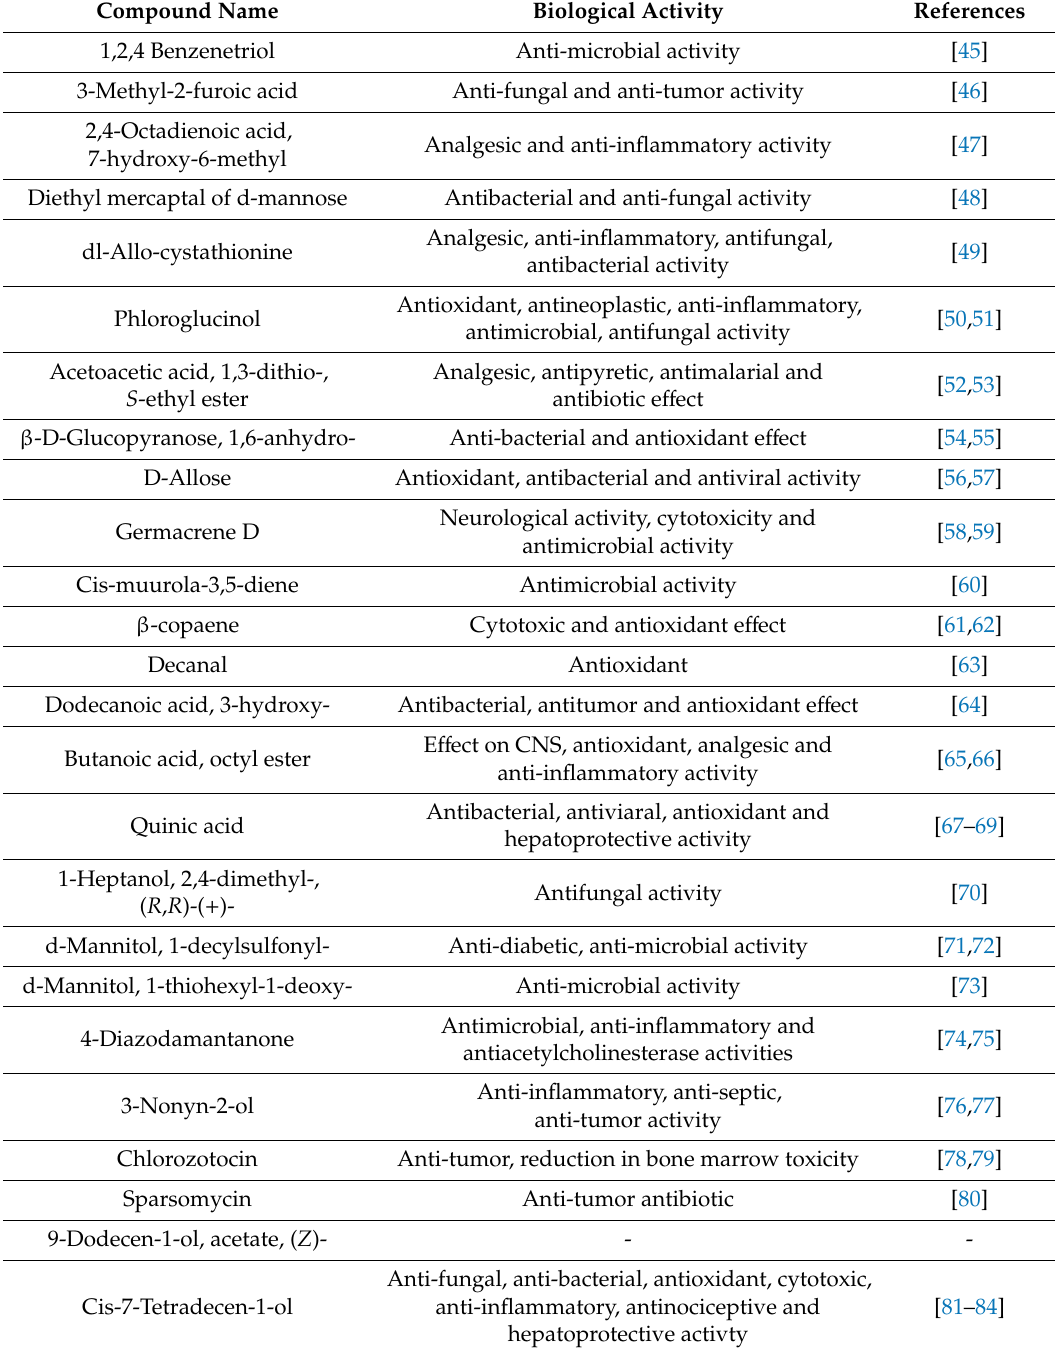
Table 6. Biological activities of selected compounds from